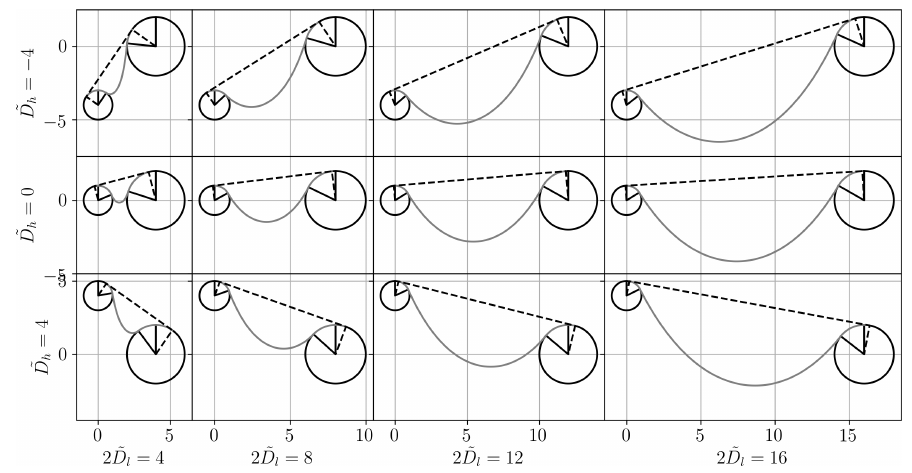
Figure 10. The optimum length.